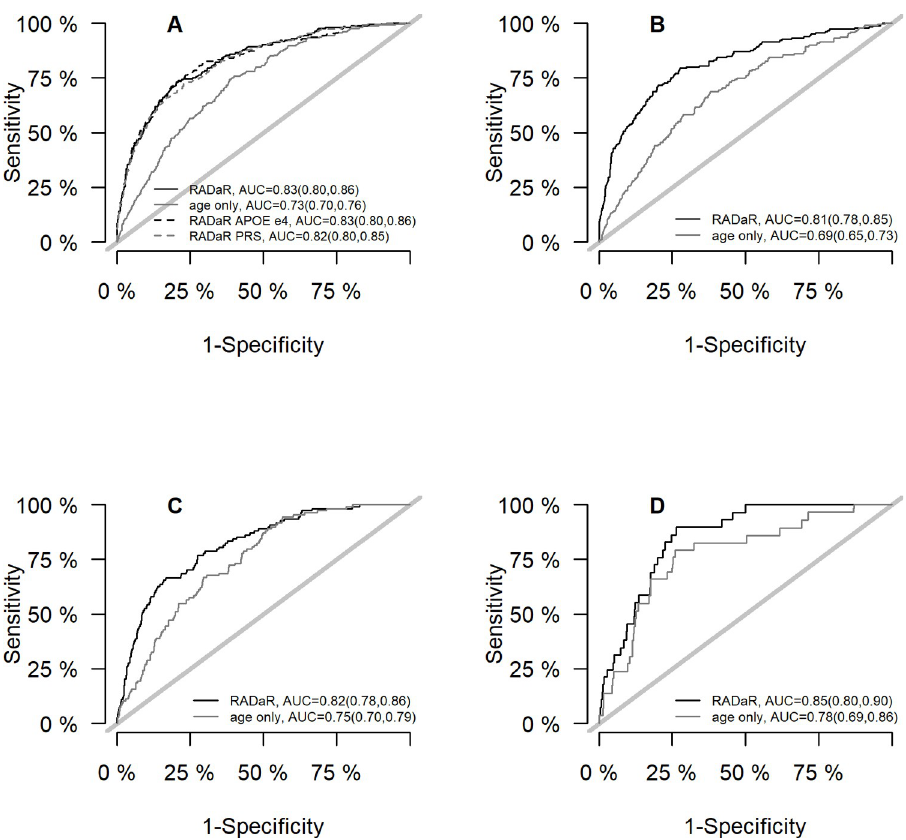
Fig 3. ROC curve and AUC (with 95% CI) of age alone versus RADaR at 3-year prediction time. (A) all with genetics, (B) Derivation cohort, (C) Validation cohort, (D) Generalization cohort.